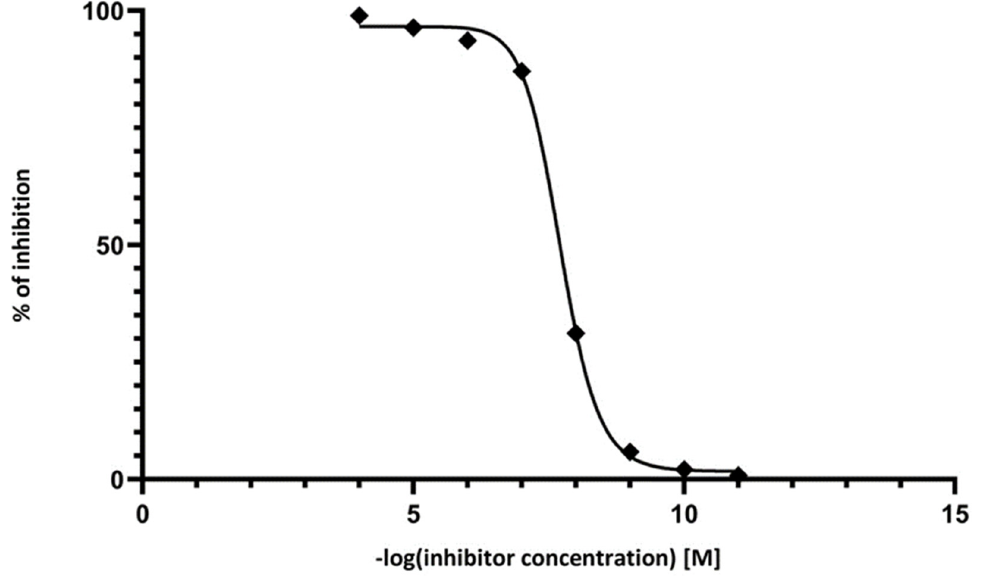
Figure 3. The enzyme-inhibitor mixture was preincubated for 30 min at 30 °C before the activity of